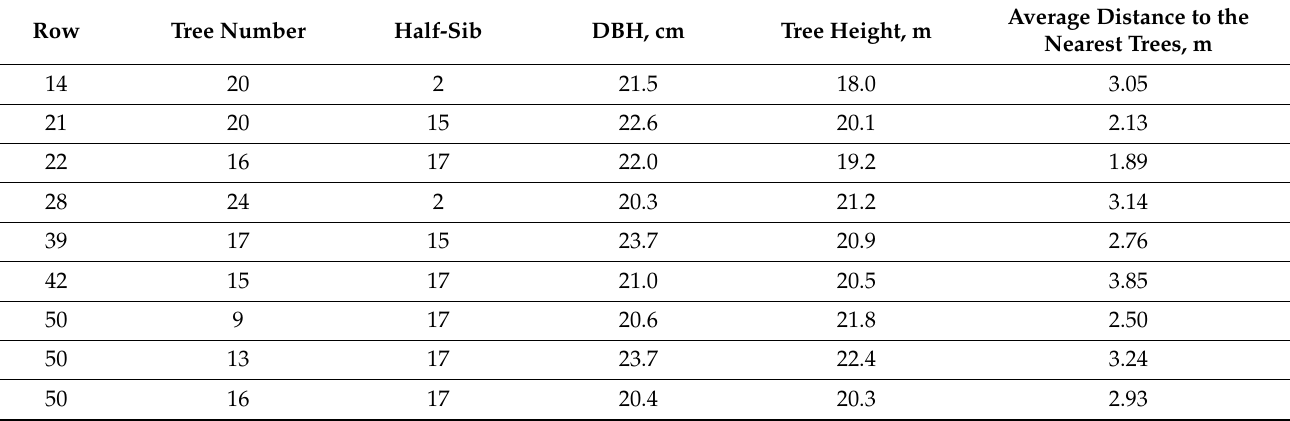
Table 10. Characteristic of the best trees